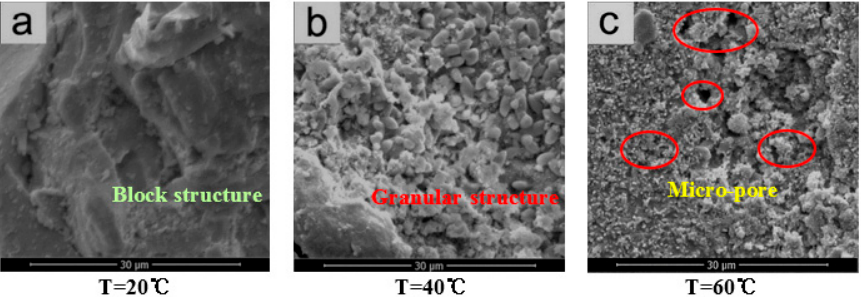
Figure 8. SEM photos of ceramsite concrete curing at different temperatures [65].